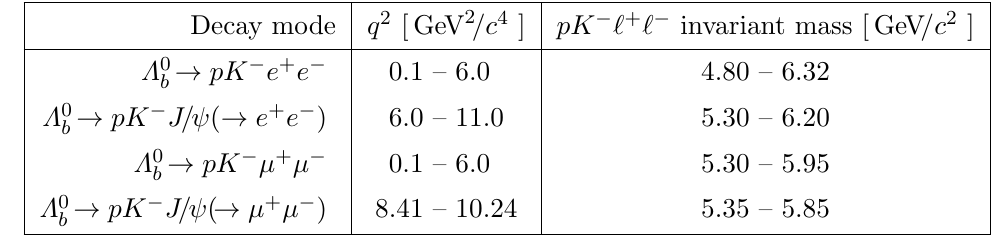
Table 1. Resonant and nonresonant mode q 2 and pK (cid:0) ‘ + ‘ (cid:0) invariant-mass ranges. For the resonant modes, the four-body invariant mass is computed with a J= mass constraint on the dilepton system.